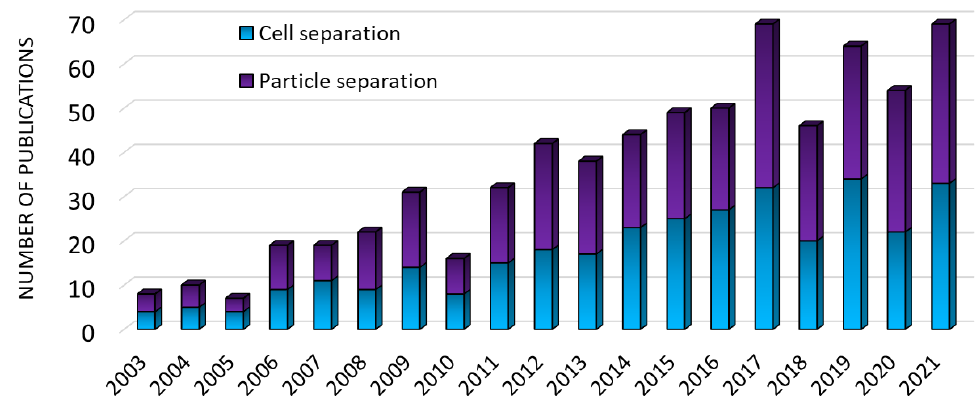
Figure 1. Number of documents published in the last two decades (up to 2021) related to the use of numerical modeling for the microfluidic separation of particles and cells, and found in the Scopus database using the keywords “cell separation”, “particle separation”, “simulation”, and “mi- crofluidics”.